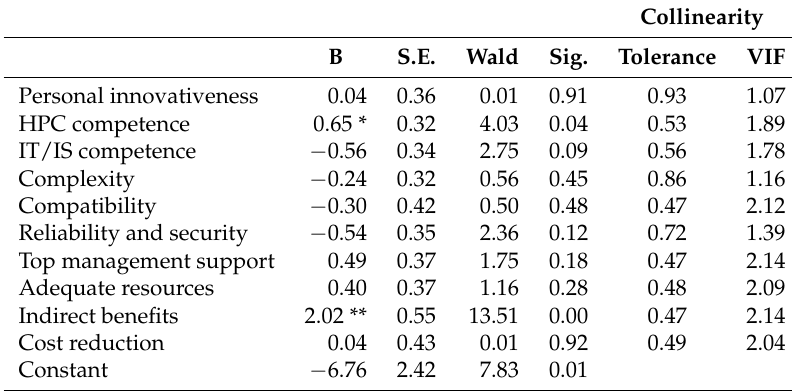
Table 5. Logistic regression